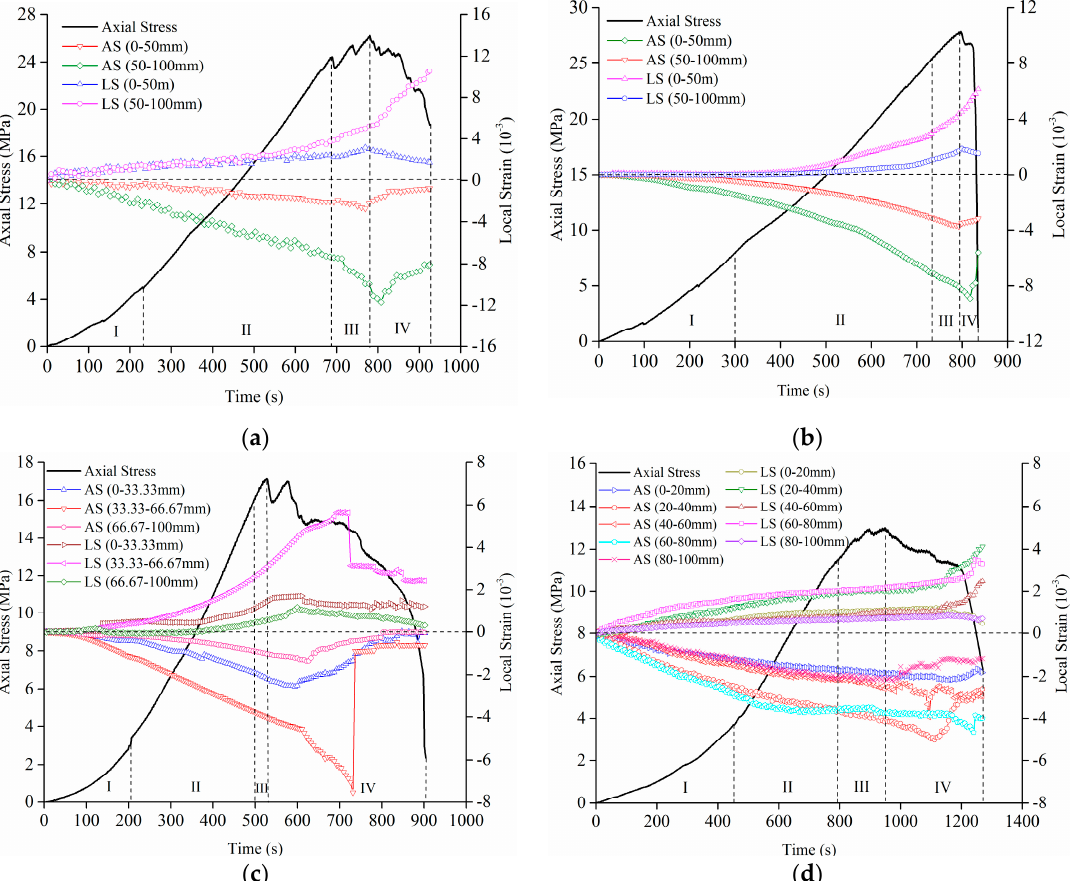
Figure 11. Evolution of the axial stress and local strain for sandwiched coal-rock specimens at different loading times. ( a ) C-R; ( b ) R-C; ( c ) R-C-R; ( d ) R-C-R-C-R.